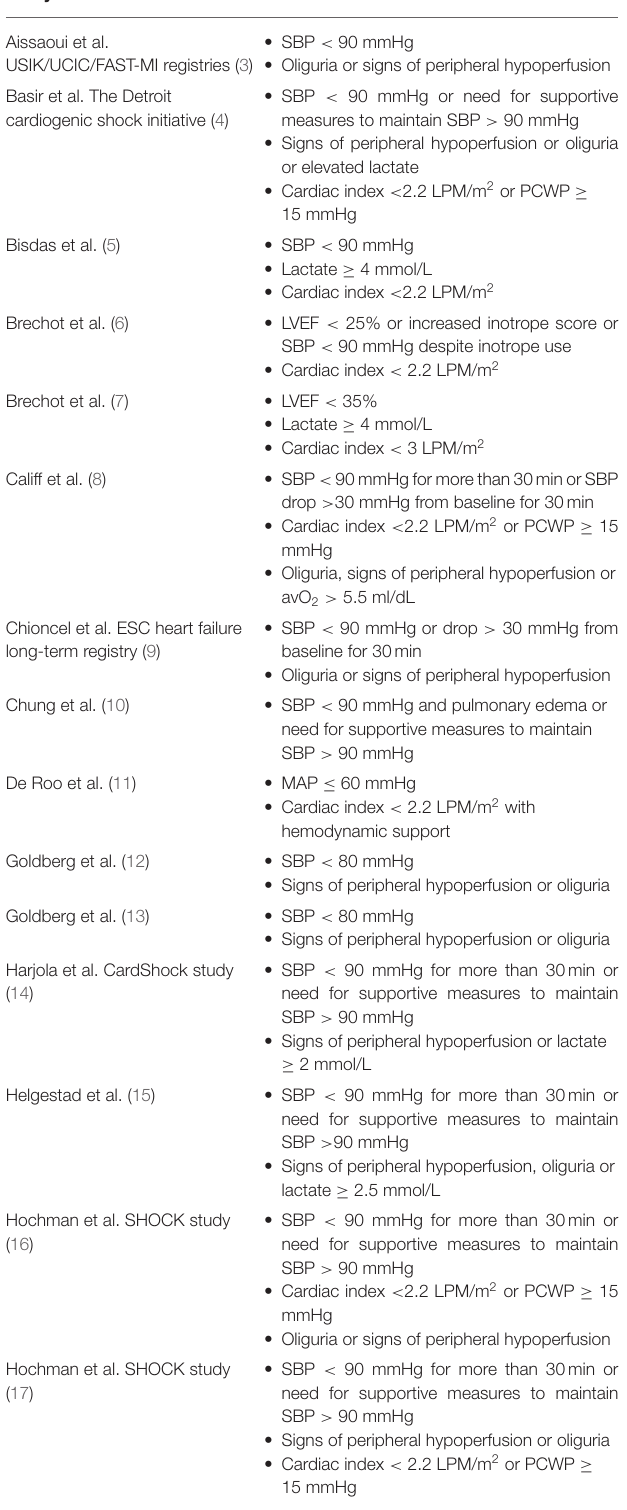
TABLE 1 | The broad range of criteria utilized to define cardiogenic